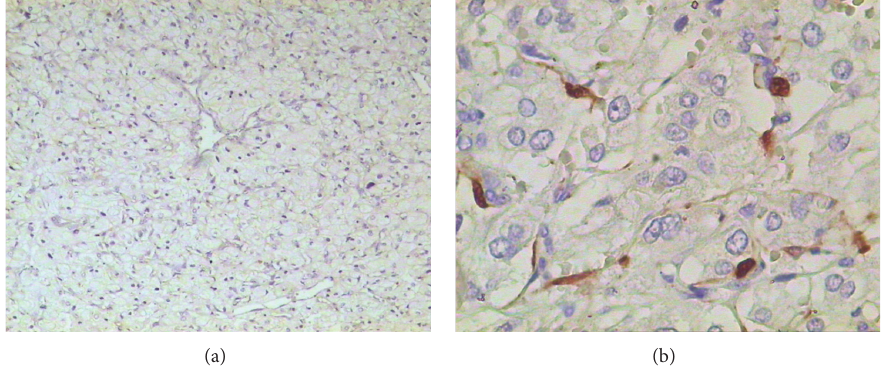
Figure 6: The proliferation index of Ki-67 (clone MIB-1) detection in the tumor is very low ( < 1%).